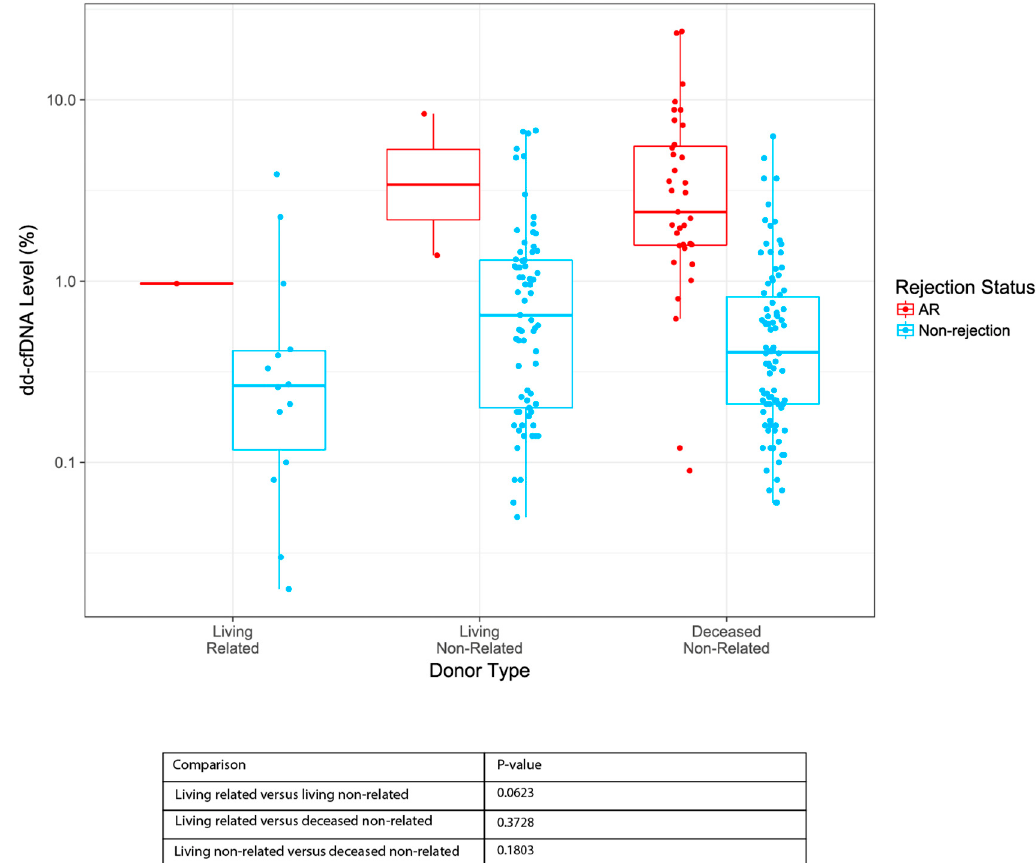
Figure 6. Relationship between dd-cfDNA and donor type. Boxes indicate inter-quartile range, horizontal lines represent medians. p -values for dd-cfDNA an ANOVA Wald-test with Kenward–Roger approximation for the degrees of freedom was followed by Tukey’s post-hoc test. AR, active rejection.